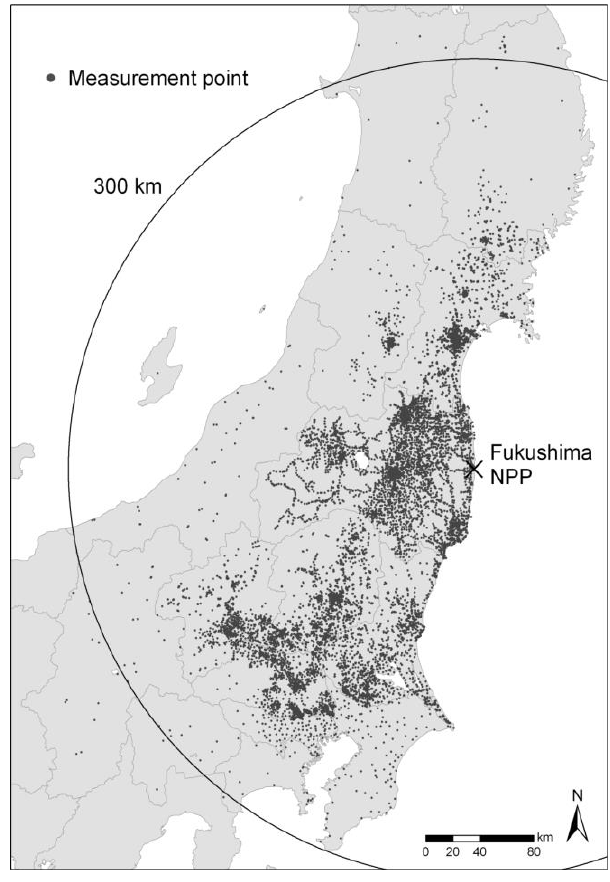
Figure 1. Locations of the Fukushima Daiichi Nuclear Power Plant and dose measurement points (n = 11,824). The measurement points were available on the TEPCO, MEXT, local government, and Fukushima University